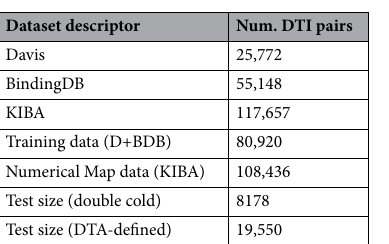
Figure 1. Conceptual overview of the proposed MUSDTI predictor.